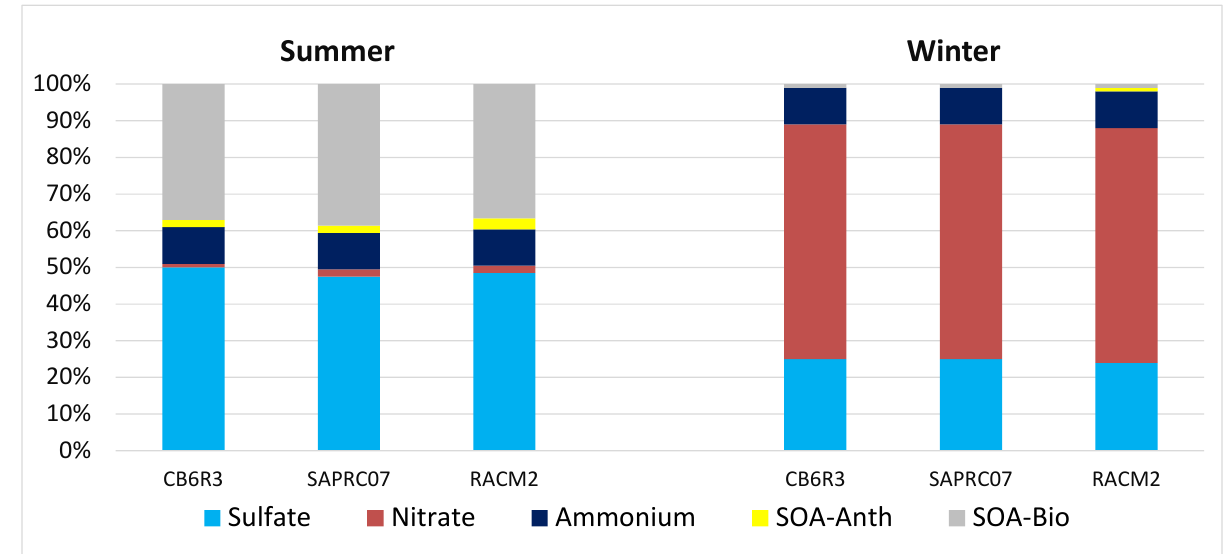
Figure 9. Percentage relative compositions of key species for PM 2 . 5 predicted during summer ( left ) and winter ( right ).